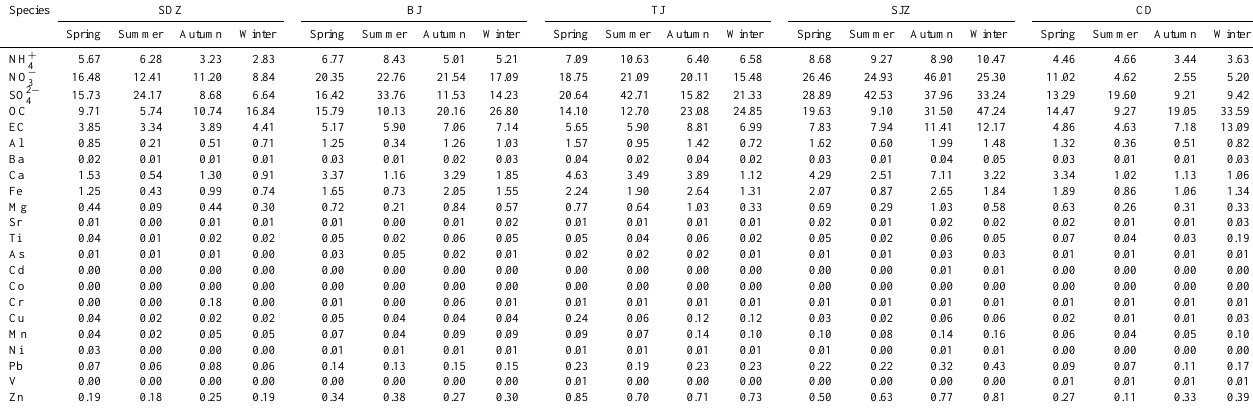
Table 3. Seasonal average concentrations of major components at the five sites (µgm − 3 )